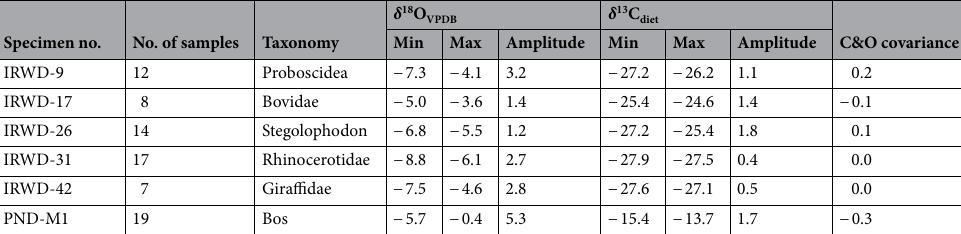
Table 1. Summary statistics for the intra-tooth serial sampling. IRWD specimens are from the Miocene locality, whereas PND-M1 is a modern reference sample also originating from the Central Basin of Myanmar.